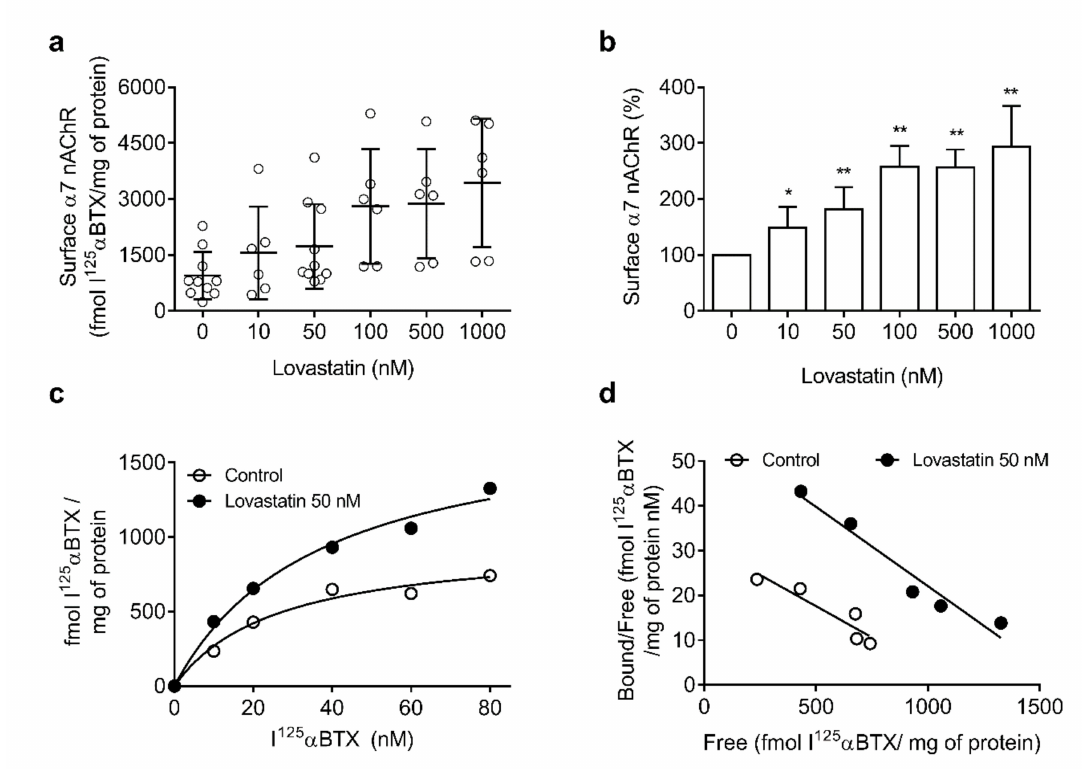
Figure 3. Lovastatin treatment increases surface α 7 nicotinic acetylcholine receptor (nAChR) levels in cultured hippocampal neurons. ( a ) Cultured hippocampal neurons were treated with di ff erent lovastatin concentrations for a total of 14 days. At the end of the incubation, neurons were washed, fixed with paraformaldehyde (PF) for 15 min, and labeled with I 125 - α -bungarotoxin ( α BTX). Neurons were washed and specific I 125 - α BTX binding was measured. Data were obtained from at least six experiments ( n = 6–17) and represented as a scatter plot to show the variability. ( b ) Normalized data obtained in ( a ), * p < 0.01 ** p < 0.0025. ( c , d ) Representative saturation curve and Scatchard plot of data obtained as with 50 nM